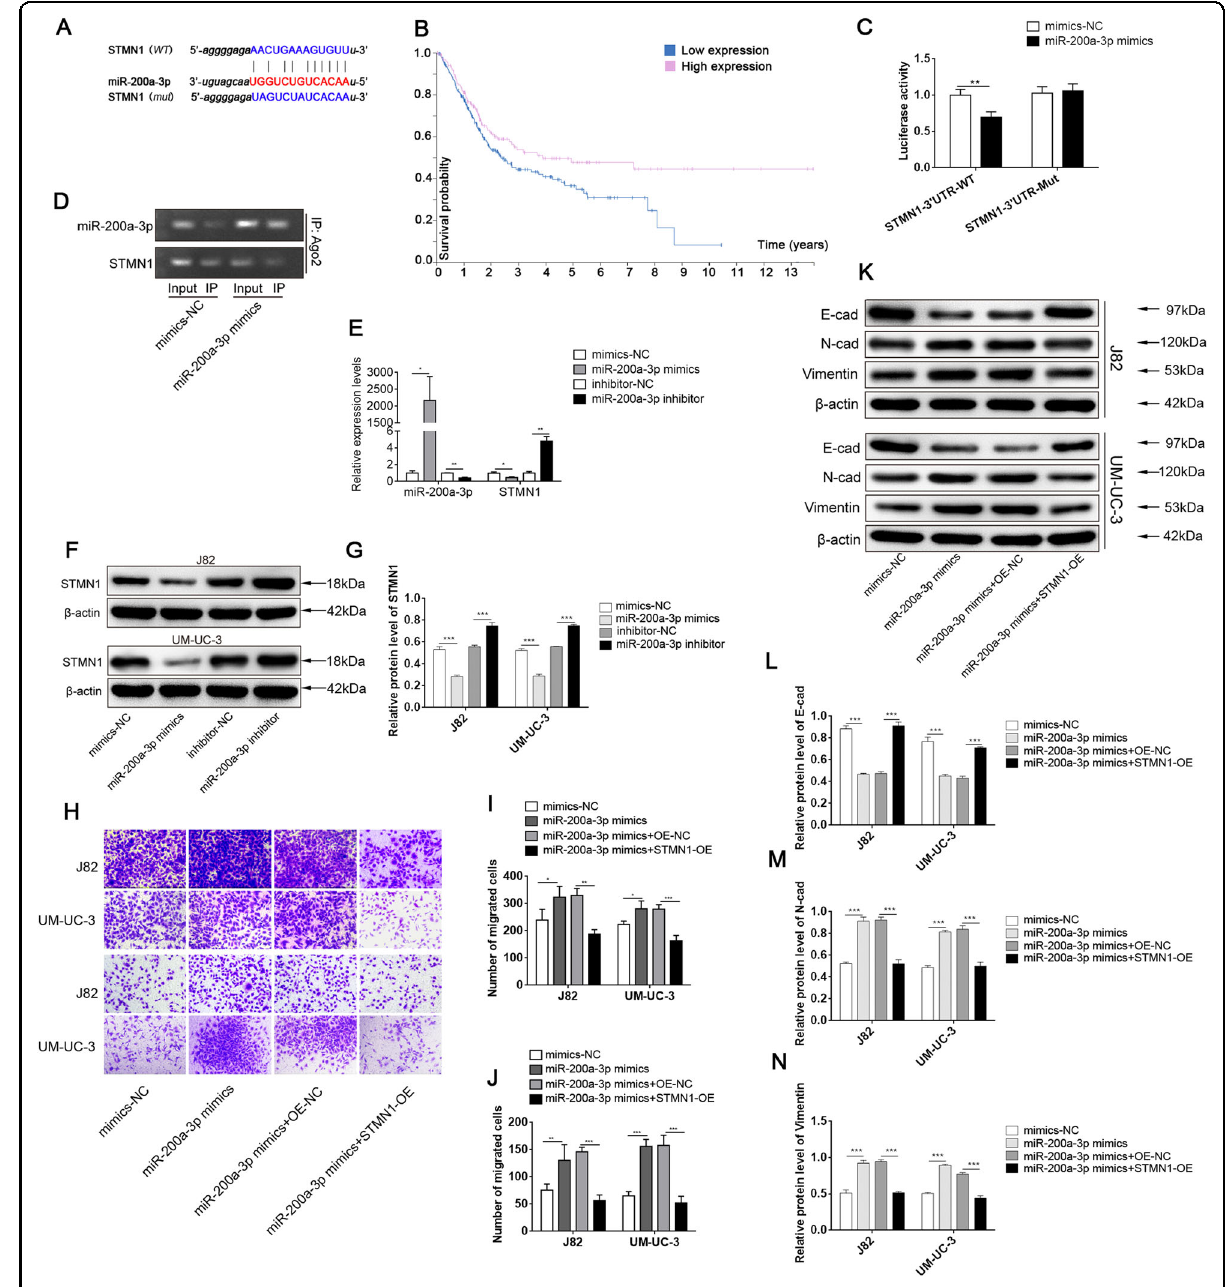
Fig. 5 miR-200a-3p promoted EMT by targeting STMN1. A Complementary binding sites between miR-200a-3p and STMN1. B The survival curves for 406 bladder cancer patients are presented. C Relative luciferase activities of WT-STMN1 or MUT-STMN1 in miR-200a-3p transfected cells. D The RIP assay was performed to verify miR-200a-3p binding with STMN1 mRNA. E Relative miR-200a-3p and STMN1 mRNA levels in transfected cells were examined by qRT-PCR. F – G Relative STMN1 protein levels in transfected cells were detected by western blotting. H – J Transwell assay to analyse the migration and invasion of transfected cancer cells. K – N Relative protein levels of EMT-related proteins in transfected cells. *** P < 0.001, ** P < 0.01 and * P <